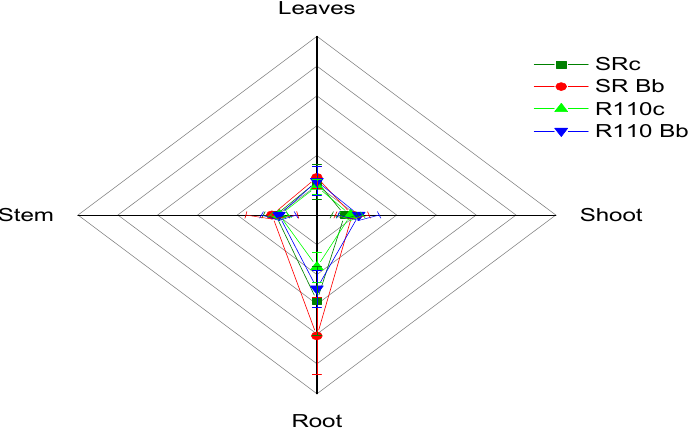
Figure 4. Two-dimensional presentation of dry weight of plant parts variables (Stem, Leaves, Shoot, Root) of endophyte-free V. vinifera plants (control) and plants infested with B. bassiana (OriginPro 9.0) . Table 2. Mean (±sd; n = 50) plant growth parameters of endophyte-free V. vinifera plants (control) and plants infested with B. bassiana . Means of the same row followed by the same letter are not significantly different ( p < 0.05). Plant Growth Parameters